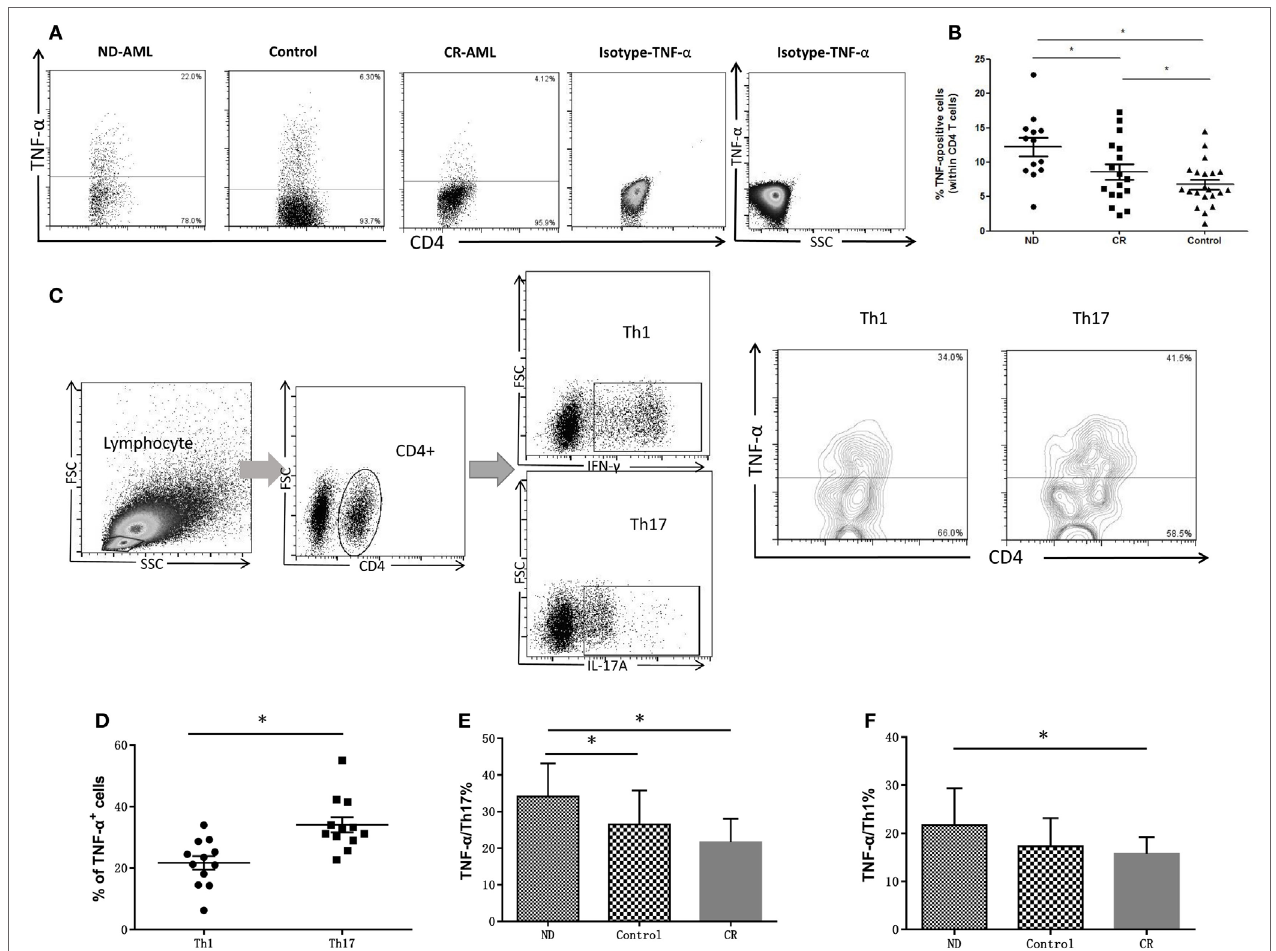
FigUre 3 | The intracellular tumor necrosis factor (TNF)- α expression in peripheral blood (PB) CD4 + T cells from acute myeloid leukemia (AML) patients and healthy controls. (a) Representative flow plots of intracellular TNF- α expression in PB CD4 + T cells from AML patients and healthy controls. Isotype for TNF- α was also performed. (B) The intracellular TNF- α expression was increased significantly in PB CD4 + T cells of newly diagnosed (ND) AML compared with complete remission (CR) patients or controls. (c) Representative flow plots of intracellular TNF- α expression by T helper (Th)17 and Th1 cells in PB of ND AML patients. (D) Intracellular TNF- α expression by Th17 cells was significantly higher than that of Th1 cells in PB of ND AML patients. (e) Intracellular TNF- α expression by Th17 cells in PB of ND AML patients was significantly higher than that of Th17 cells in PB of controls and CR patients. (F) Intracellular TNF- α expression by Th1 cells in PB of ND AML patients was significantly higher than that in controls or CR patients.